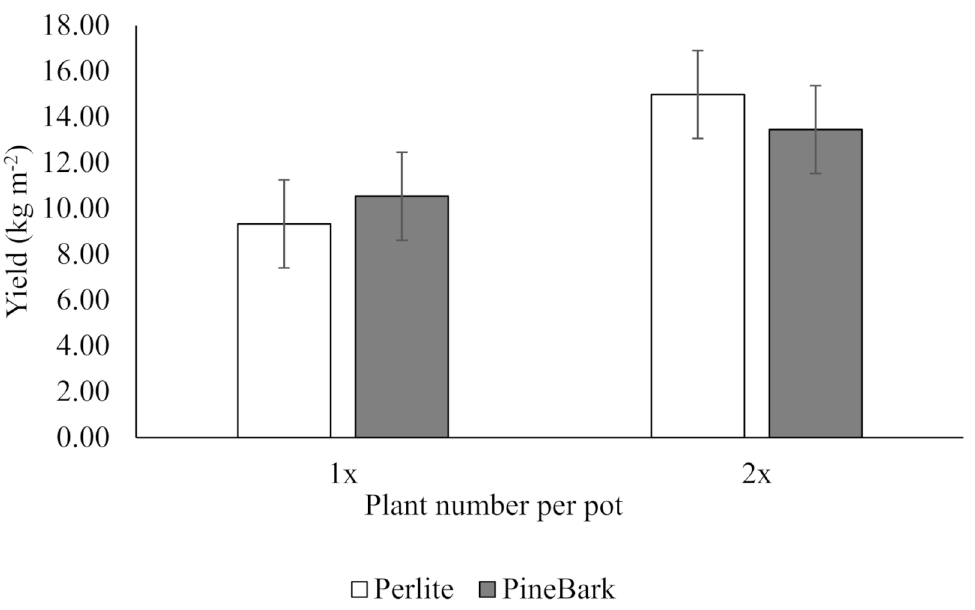
Figure 1. Yield per square meters of cucumber in 2016 trial across seasons of spring and winter–spring. Error bars are ± standard error. 1 × = one plant per pot; 2 × = two plants per